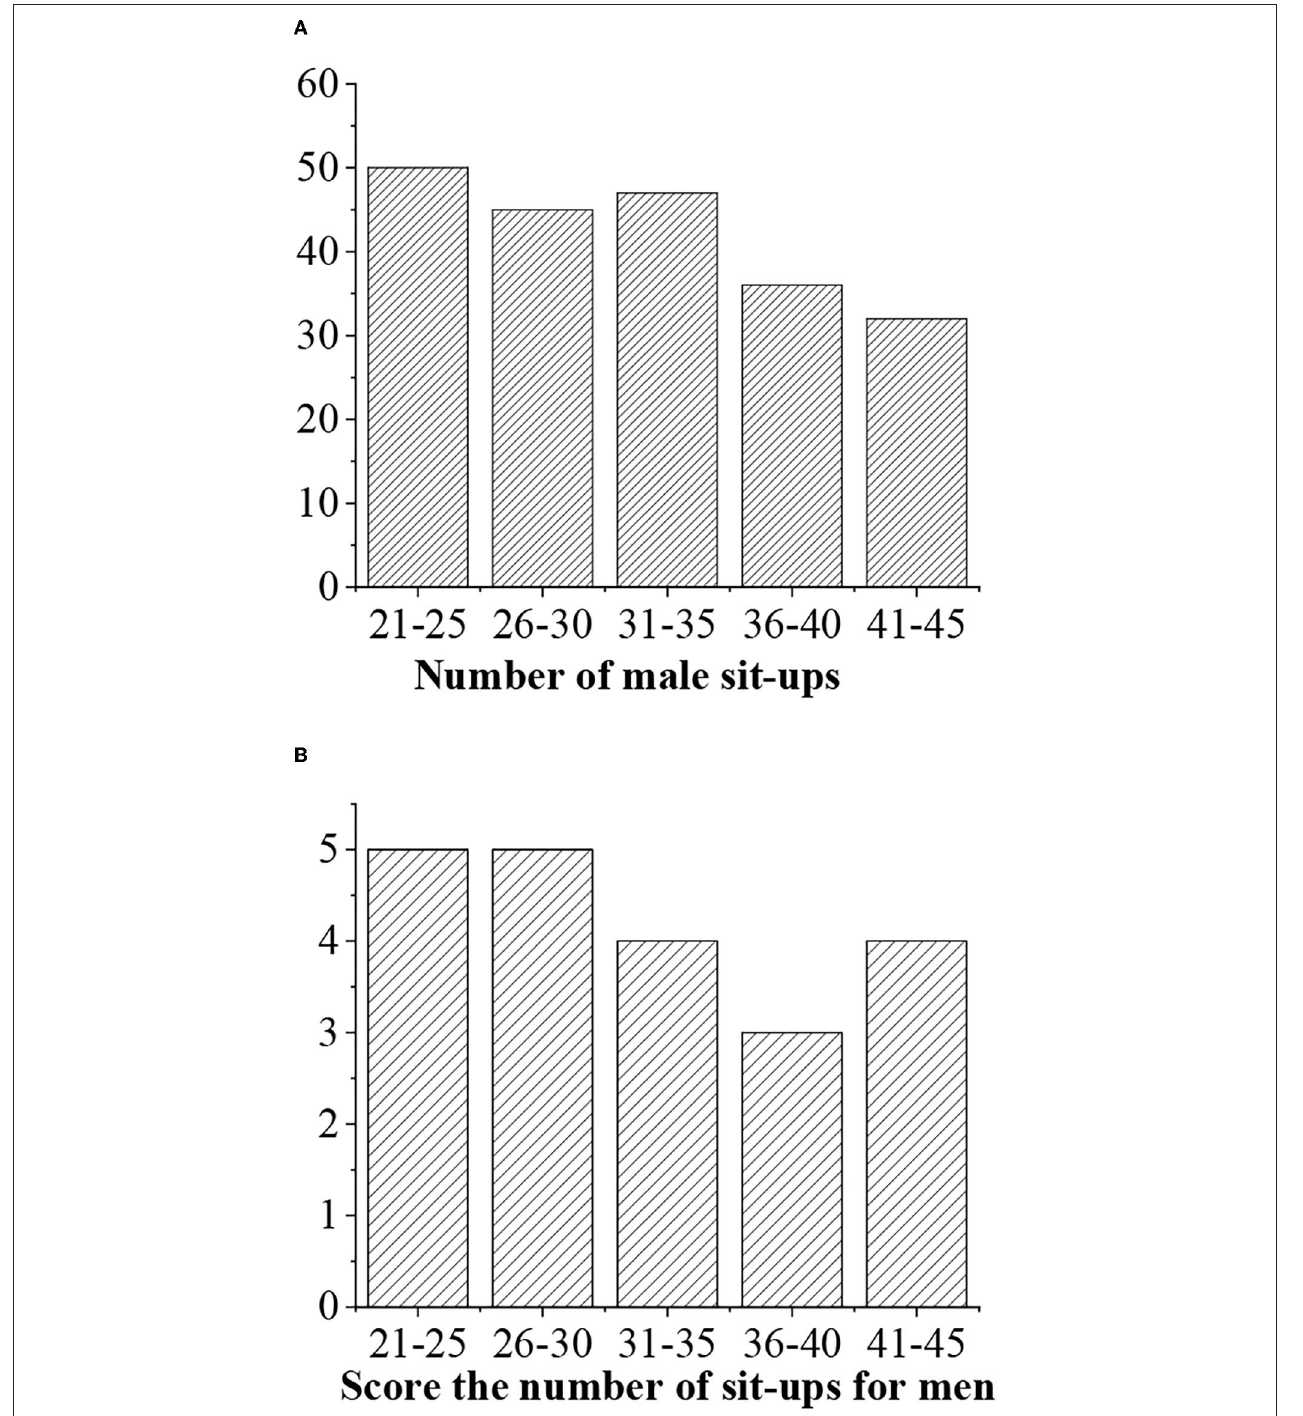
FIGURE 10 | (A) Statistical average sit-ups value for men of different ages. (B) Sit-ups score. The grip strength can be graded as follows: > 55 (“excellent,” 5 points), 40–50 (“good,” 4 points), 30–40 (“medium,” 3 points), < 30 (“general,” 3 points), and < 20 (“alert,” 2 points) ( Figures 6 , 7 ).